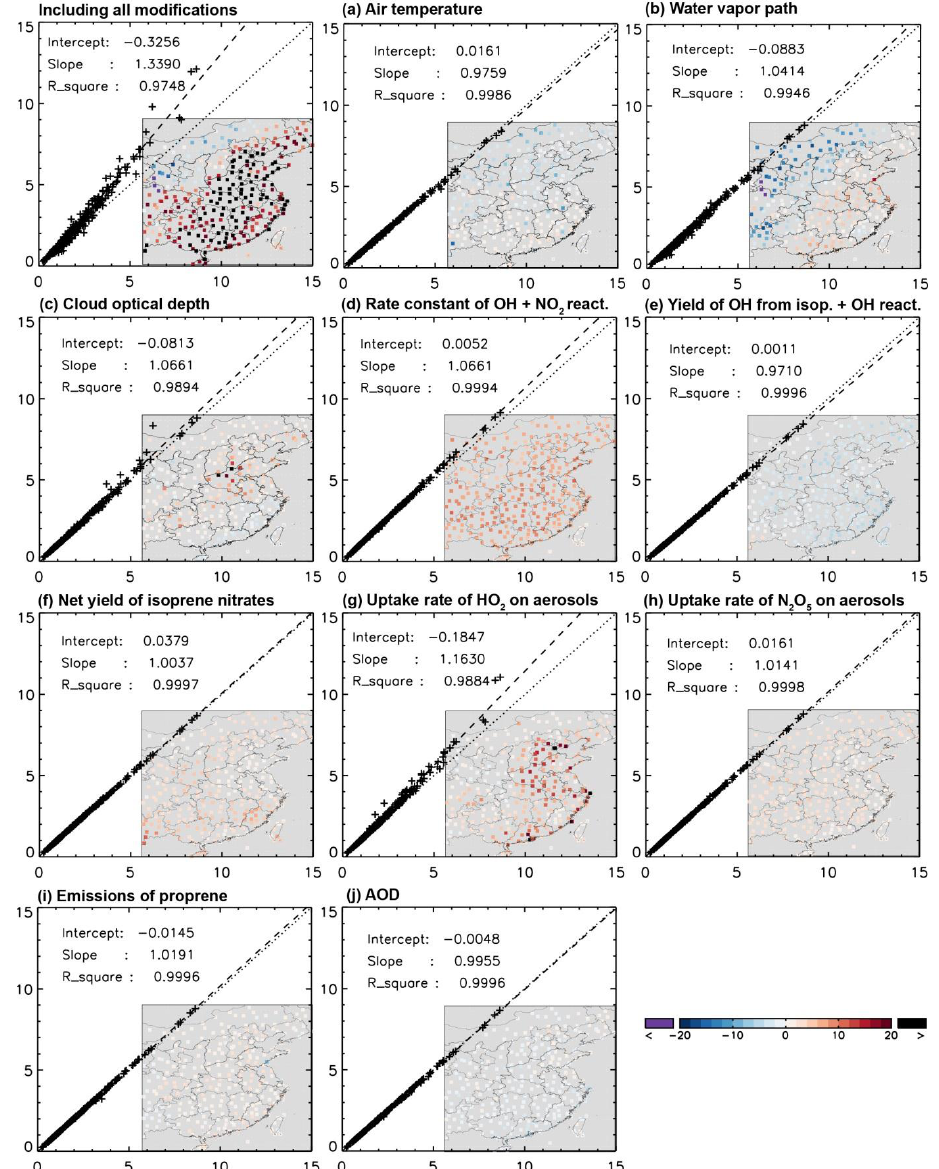
Fig. 13. Scatter plot for model NO 2 columns (10 15 molec.cm − 2 ) in July 2006 without (x-axis) and with (y-axis) post-model modifications accounting for errors in meteorological and chemical parameters. Cases (a–j) are described in order in Table 2. Embedded in each panel are the respective statistics from the RMA regression and the spatial distribution of their percentage